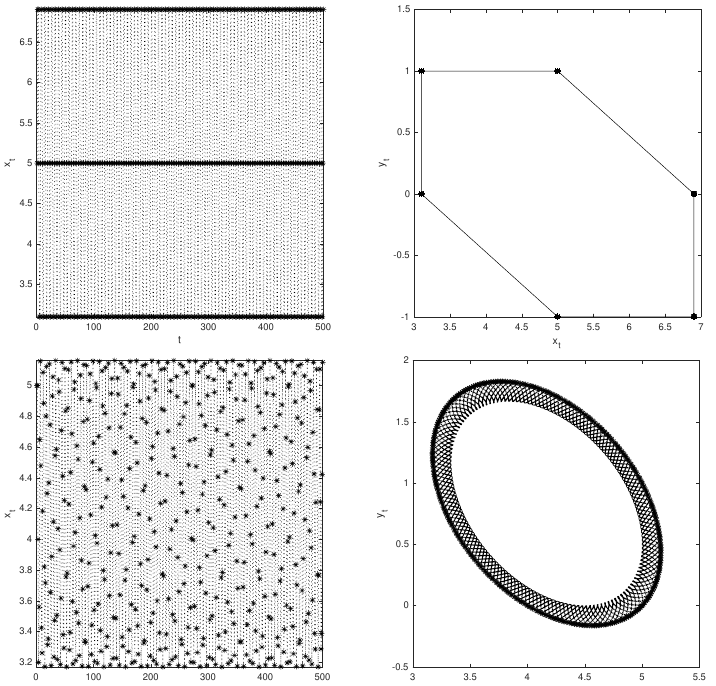
Figure 5. The ( top-left ) shows the price evolution and ( top-right ) the phase space of the fundamental map dynamics with a = 1, b = 1.9 and c = 1 ; while ( bottom-left ) and ( bottom-right ) show the price b evolution and the phase space of fundamental map dynamics with a = 0.8, b = 1 and c =